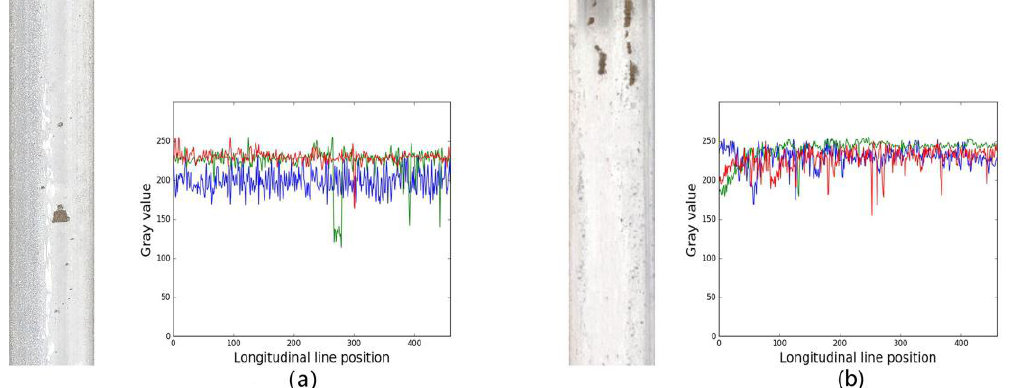
Figure 4. The gray value along longitudinal line of an image. ( a ) The gray value of 10th (red), 80th (blue), 110th longitudinal line (green) of an UAV rail image form slight defects dataset. ( b ) The gray value of 10th, 80th, 110th longitudinal line of an UAV rail image form datasets of serious defects.